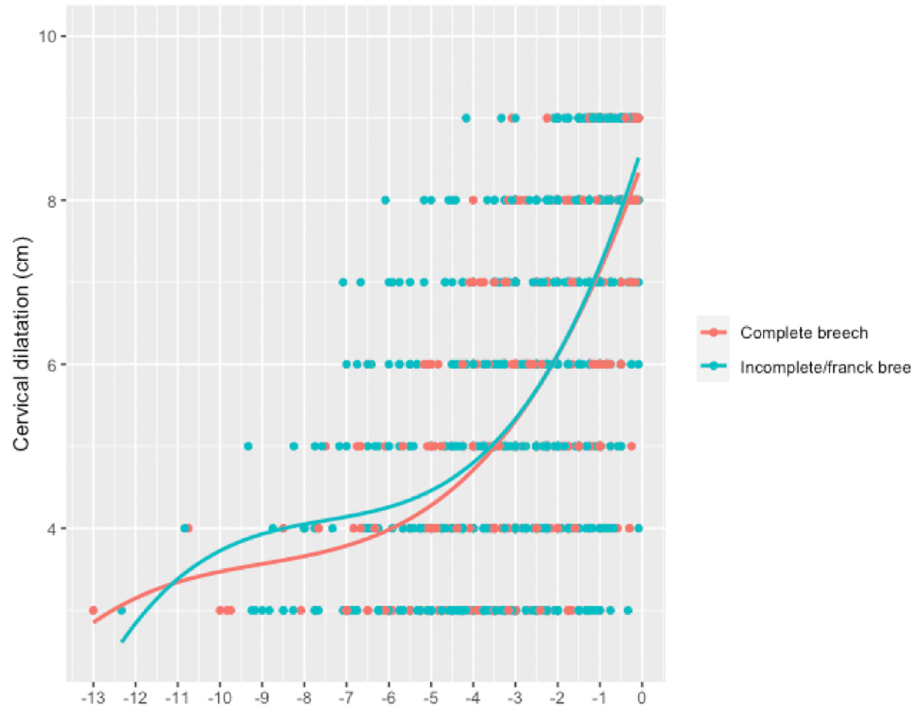
Fig 4. Cervical dilatation curves according to the type of breech